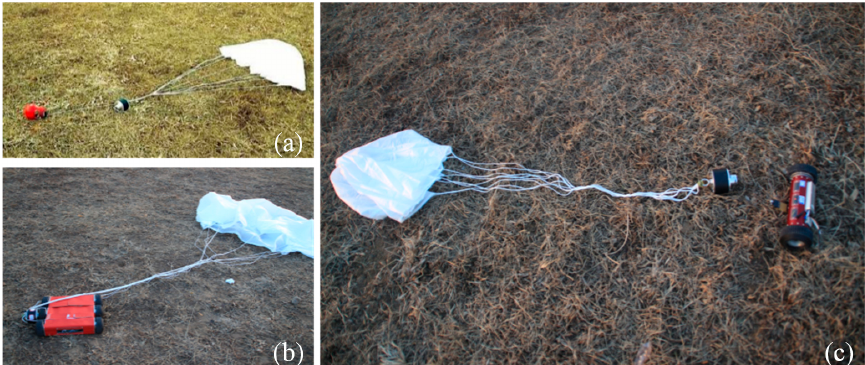
Figure 14. Successful landing and separation of robots: ( a ) FNR. ( b ) SWSR. ( c ) TWSR.